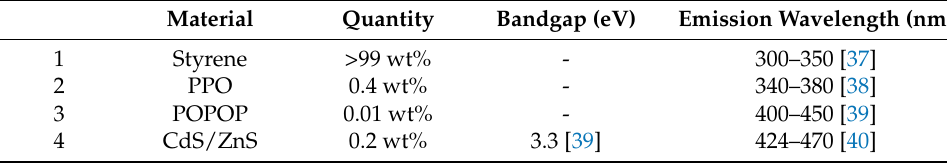
Table 1. Content and properties of materials added in this